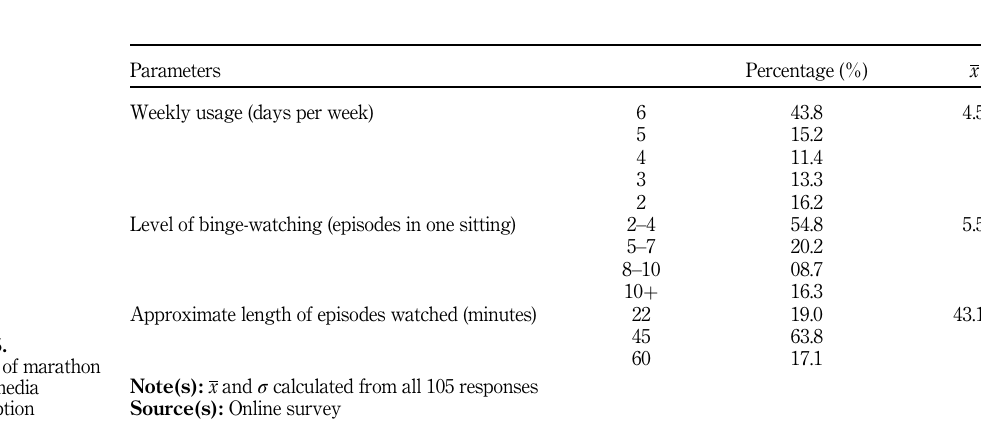
Table 4. Factors that influence marathon Netflix usage